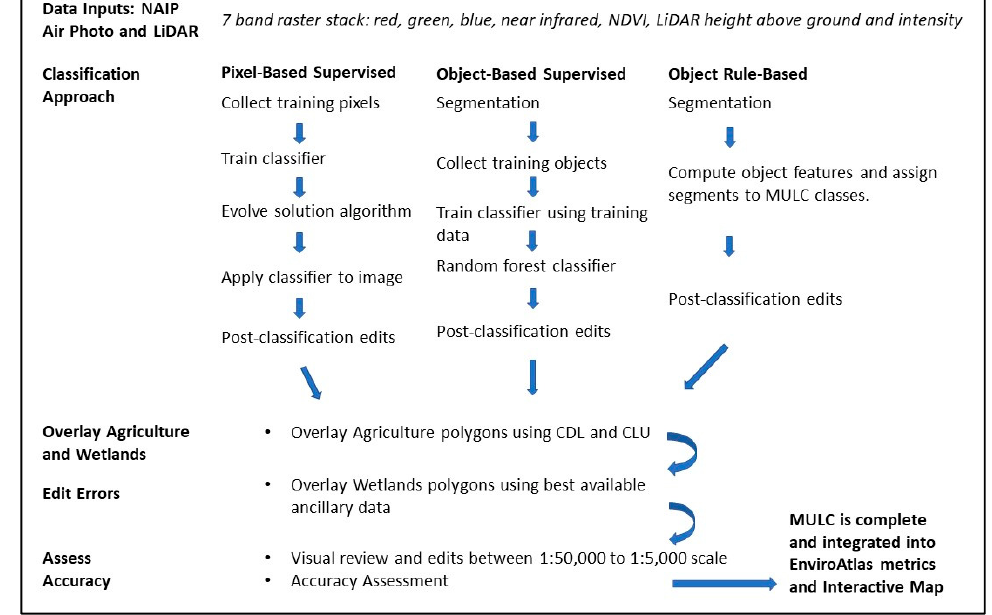
Figure 4. MULC classification workflow. MULC data are created using one of three classification methods. Abbreviations are defined in the text. Land cover datasets created by external partners are recoded to EnviroAtlas MULC classes and run through the post-classification steps (overlay, edit, assess).